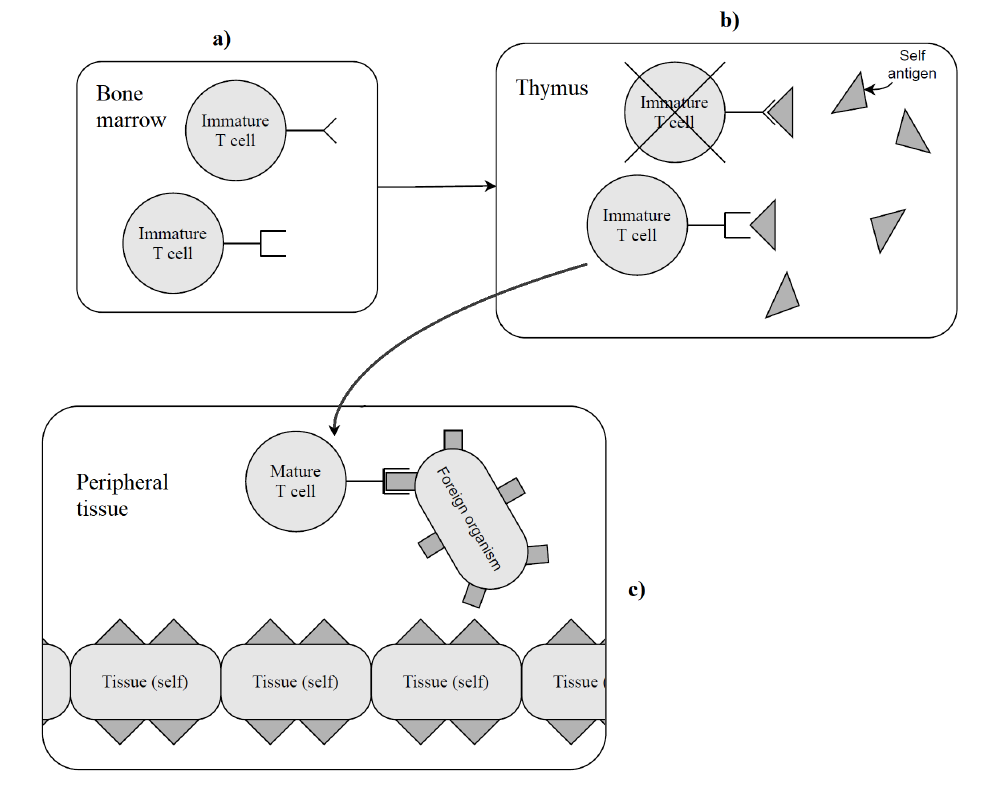
Figure 2. Simplified diagram of self–nonself theory. Note that self and also nonself antigens are immensely varied. For illustrative purposes only, in this figure all self antigens are identical. It consists of 3 main steps: ( a ) Immature T cells with various antigen receptors are produced in the bone marrow and migrate to the thymus; ( b ) In the thymus, T cells that recognize self antigens undergo apoptosis. On the other hand, T cells that don’t recognize any self antigen are allowed to live; ( c ) Mature T cells that don’t recognize self antigens are now used to recognize any non self antigen such as virus and